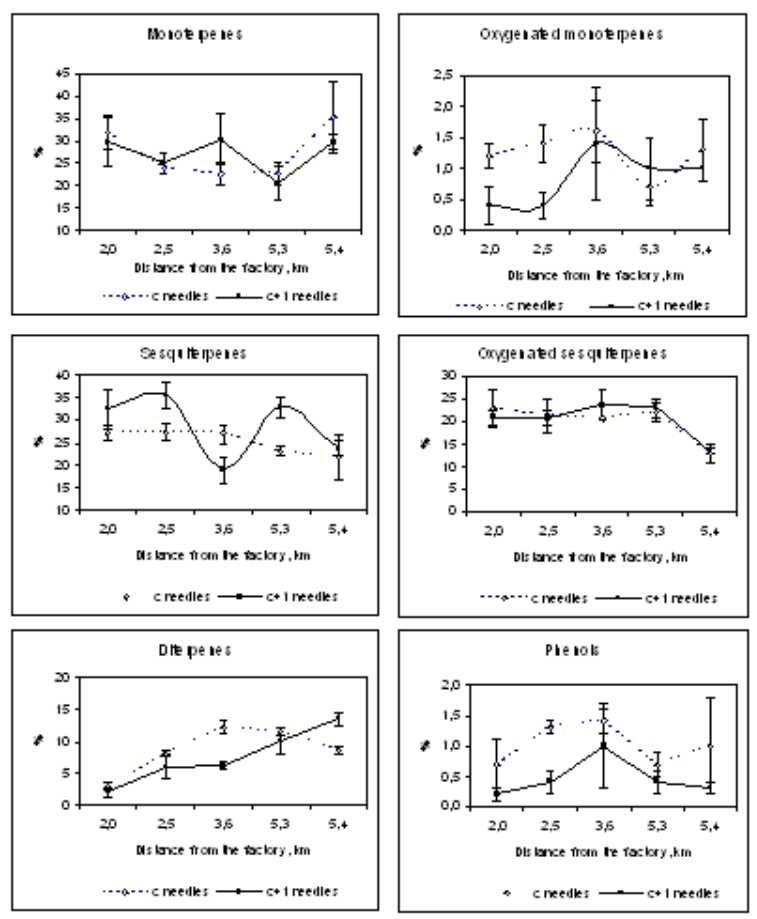
FIGURE 2. Percentage composition (mean values, n = 4) of the main classes of essential oils (monoterpenes, oxygenated monoterpenes, sesquiterpenes, oxygenated sesquiterpenes, diterpenes, phenols) in current-year (c) and 1-year-old (c+1) needles of Scots pine ( P. sylvestris L.) stands growing at different distances from the oil refinery (July 10, 2005). Error bars indicate an interval of 95%